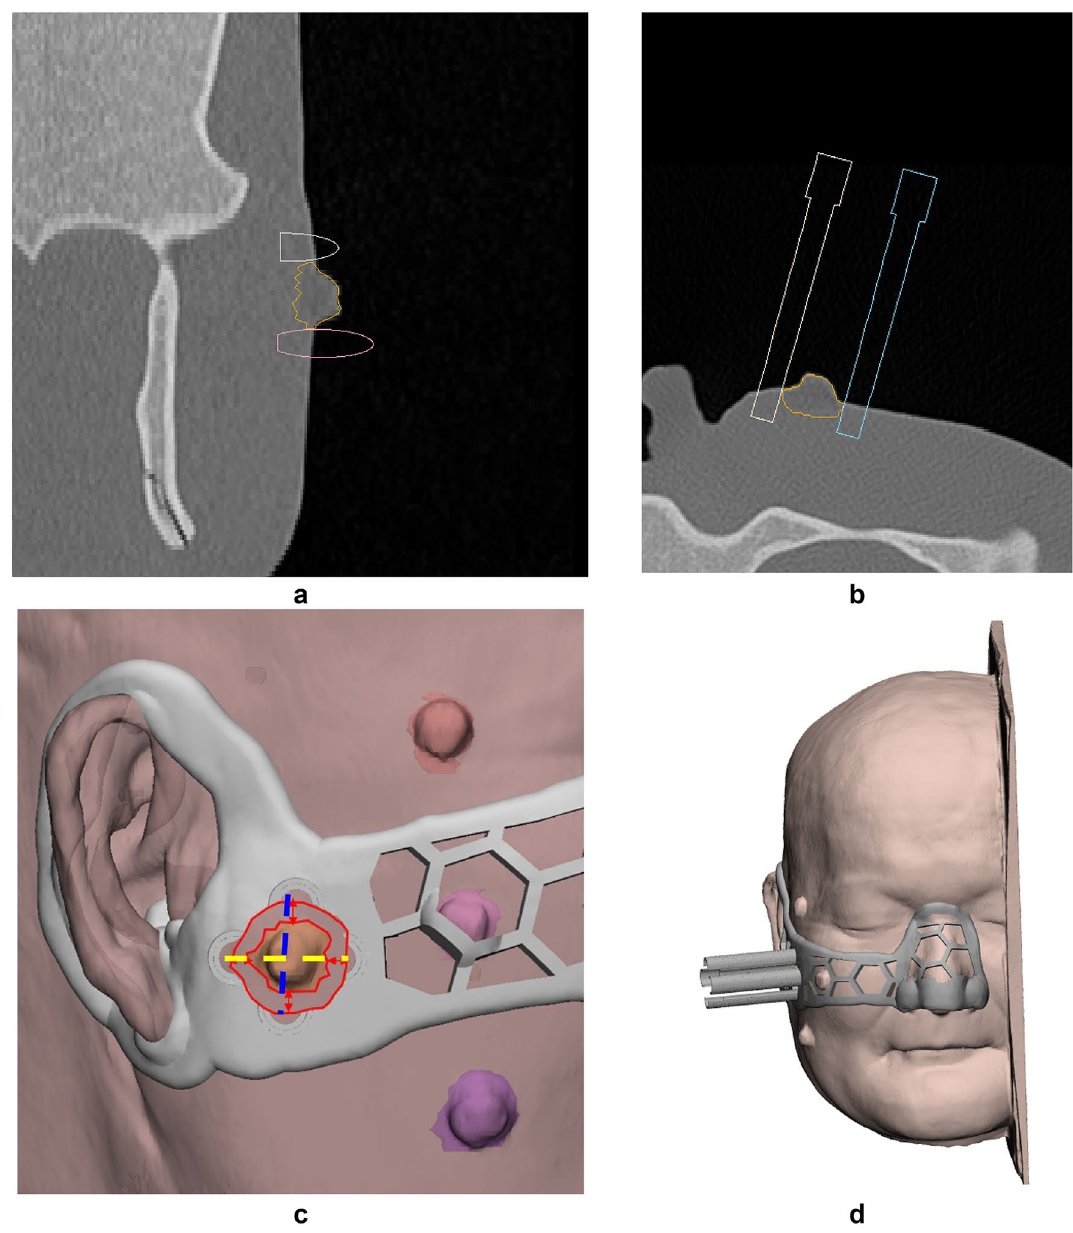
Figure 7. Visualization of scanned in-vitro phantom for evaluating skin cancer resection guide. ( a ) Sagittal view of segmented anatomies and resection point at the blue dotted line in ( c ). ( b ) Axial view of segmented anatomies and intravenous catheter injected to a depth of 7 mm at the yellow dotted line in ( c ). ( c ) Visualization of the skin cancer resection guide and safety resection margin. ( d ) Applying skin cancer resection guide for the attached regions, the combination of nose and ear. (skin, peach; a skull, light green; cancer top, red; cancer center, pink; cancer bottom, purple; cancer left, orange; cancer right,